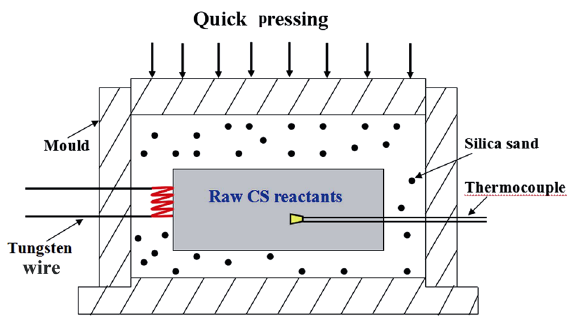
Fig. 1 Schematic diagram of the CS/QP method.